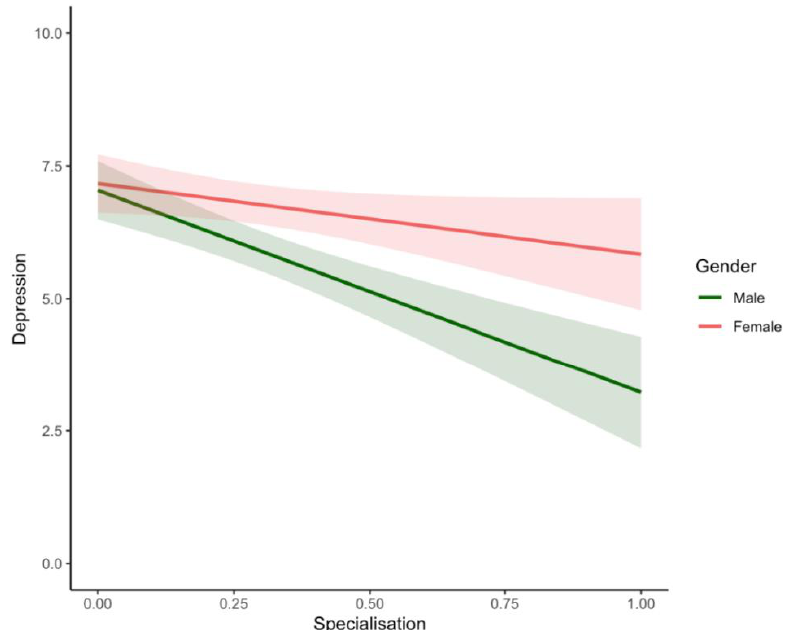
Figure 1. Simple slopes analyses demonstrating the interaction between specialisation and gender on parents’ depression in mixed-sex couples.